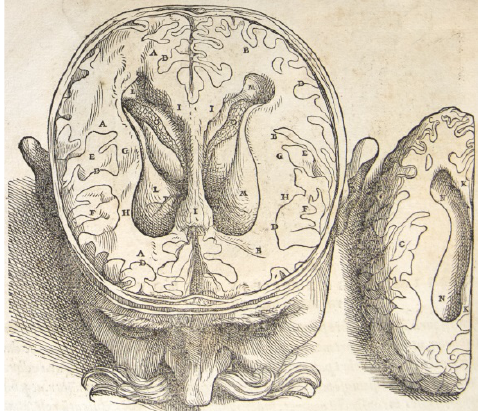
Fig. 3. The lateral ventricles from Fabrica, 1543 [15] (Image courtesy of History of Science Collections, University of Oklahoma Libraries).